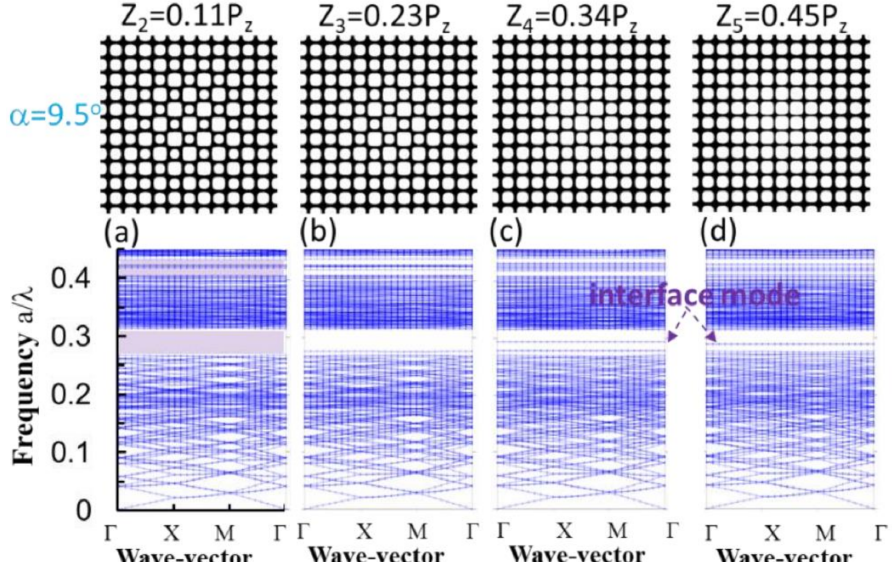
Figure 2. (Top row) Iso-intensity slices produced from the eight-beam interference with a twist angle of 9.5 degrees and used as an unit super-cell to calculate the respective photonic band structures for TE modes in ( a – d ) (bottom row) at z -locations of 0.11, 0.23, 0.34, and 0.45 P z ,